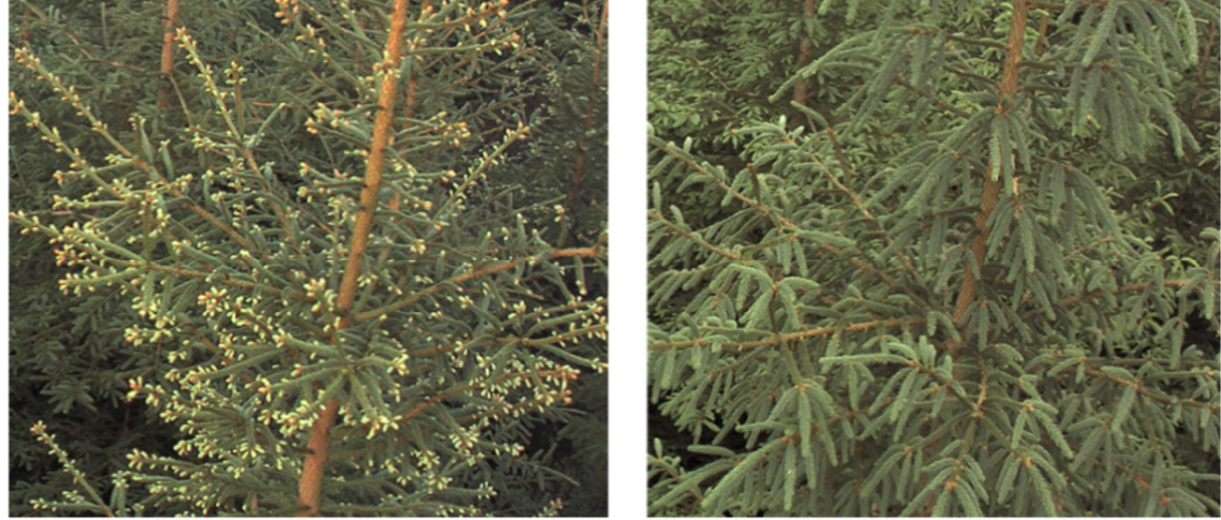
Figure 8. Bright green sprouts in spruce tree indicating the Start of Spring (SOS) ( left ), while the sprouts get a darker colour on maturation indicating the End of Spring (EOS) ( right ).